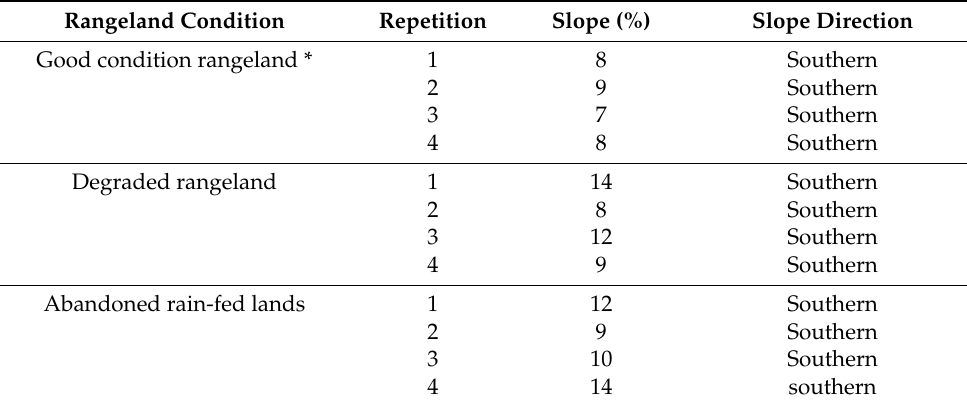
Table 1. Slope conditions of the studied region Repetition Slope